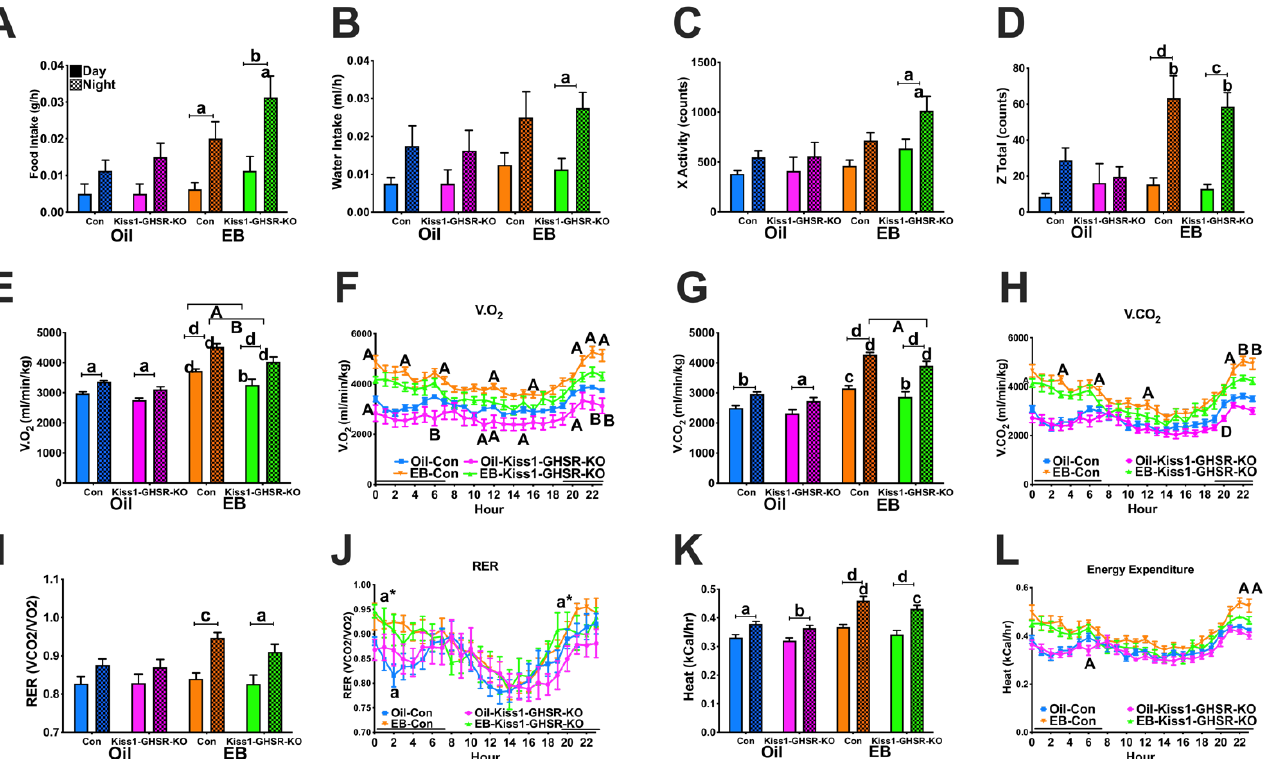
Figure 3. Metabolic Response to ovariectomy in OVX Oil- and EB-exposed control and Kiss1-GHSR KO (KO) female mice fed LFD for 8 weeks. ( A ) Food and ( B ) Water intake. ( C ) X-activity (counts), and ( D ) Z-activity (counts). ( E ) I Volume of oxygen consumption (V.O2, ml/min/kg), ( F ) Hourly Volume of oxygen consumption (V.O2, ml/min/kg). ( G ) Volume of carbon dioxide production (V.CO2, ml/min/kg), ( H ) Hourly volume of carbon dioxide production (V.CO2, ml/min/kg). ( I ) Respiratory exchange ratio (RER, V.CO2/V.O2), ( J ) Hourly Respiratory exchange ratio (RER, V.CO2/V.O2;), ( K ) Energy expenditure (kCal/hr) and ( L ) Hourly Energy expenditure (kCal/hr). Lowercase letters denote a steroid effect within genotype and time period, letters with * indicate a steroid effect in KO females only. Uppercase letters denote significance between genotypes within the same treatment. Lowercase letters above capped lines denote significance between time periods within treatment and genotype. A/a = p < 0.05; B/b = p < 0.01; C/c = p < 0.001; D/d = p < 0.0001. Data are represented as mean ± SEM and n = 8 mice per group. Data were analyzed with two-way ANOVA with post hoc Holm–Sidak’s multiple comparison test. Mice were 17–19 weeks of age during metabolic experiments.